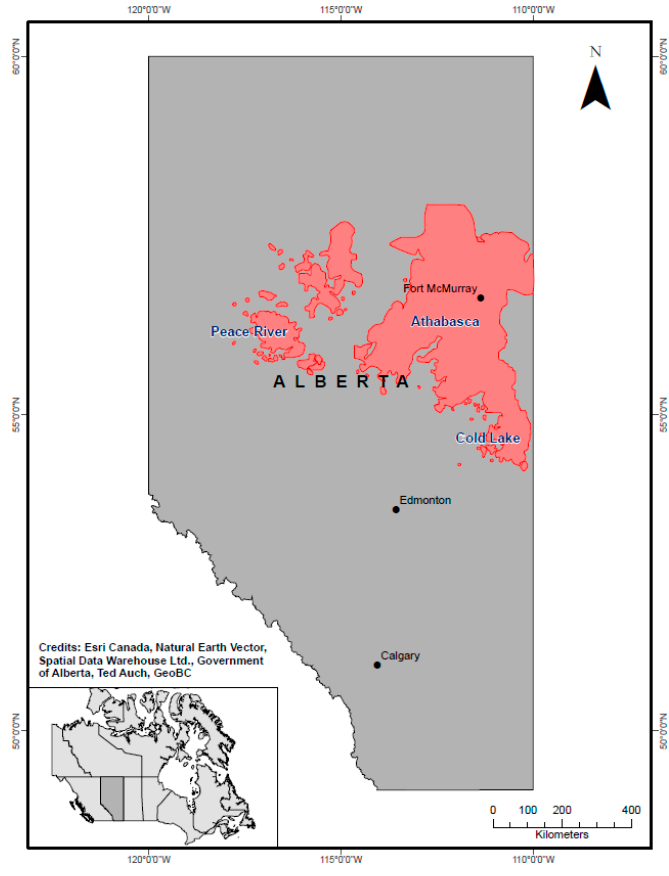
Figure 1. Location map of the Alberta Oil Sands Region (AOSR), showing the relative positions of the Peace River, Athabasca and Cold Lake oil sand deposit areas.